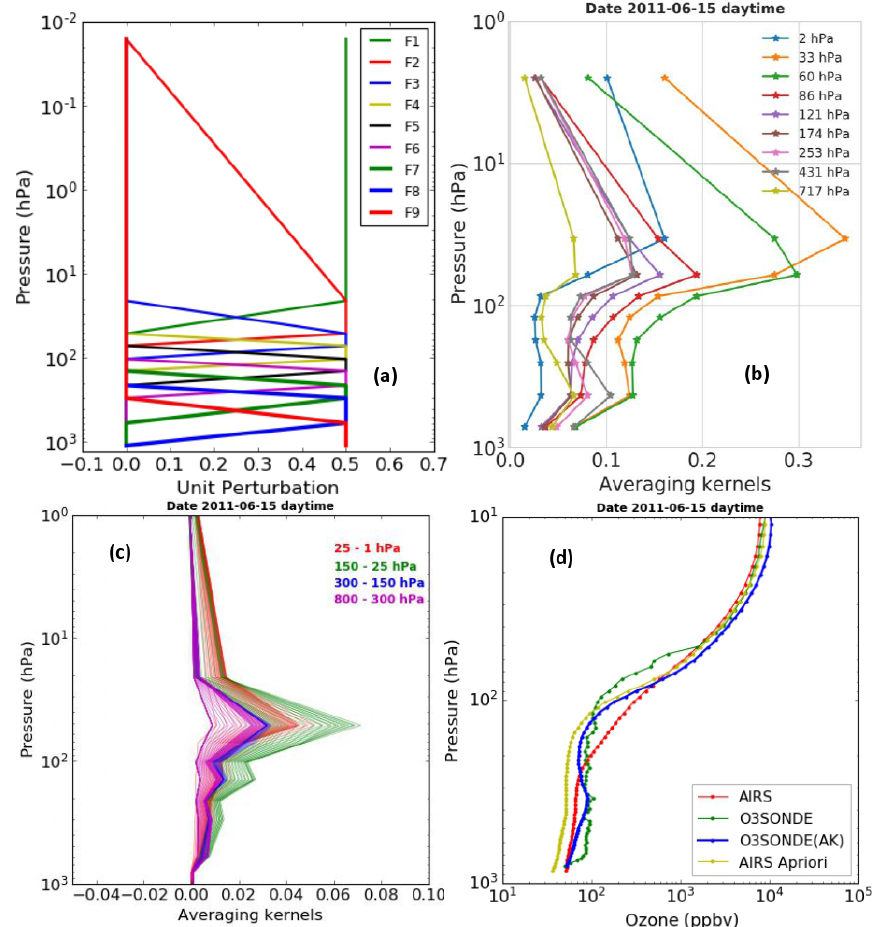
Figure 2. (a) Nine trapezoid functions used for ozone retrieval in AIRS-V6. (b) AIRS ozone averaging kernel matrix over Nainital at nine vertical grid levels. (c) Calculated AIRS averaging kernel matrices at 100 RTA grids after applying the trapezoid function. (d) An example of ozone profiles using different datasets for 15 June 2011 over the observation site.